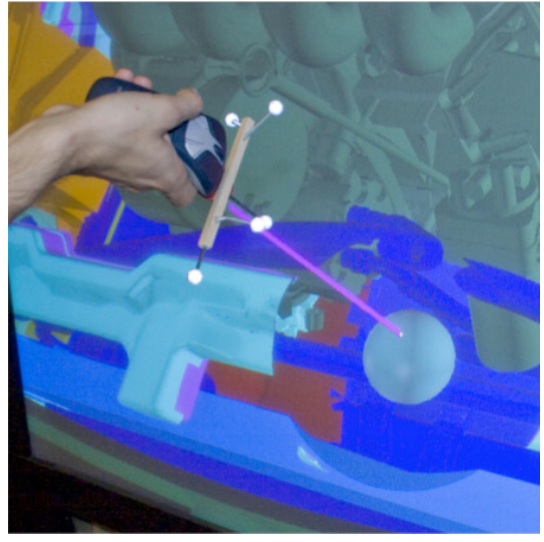
Fig. 3. Improved pointing in VR